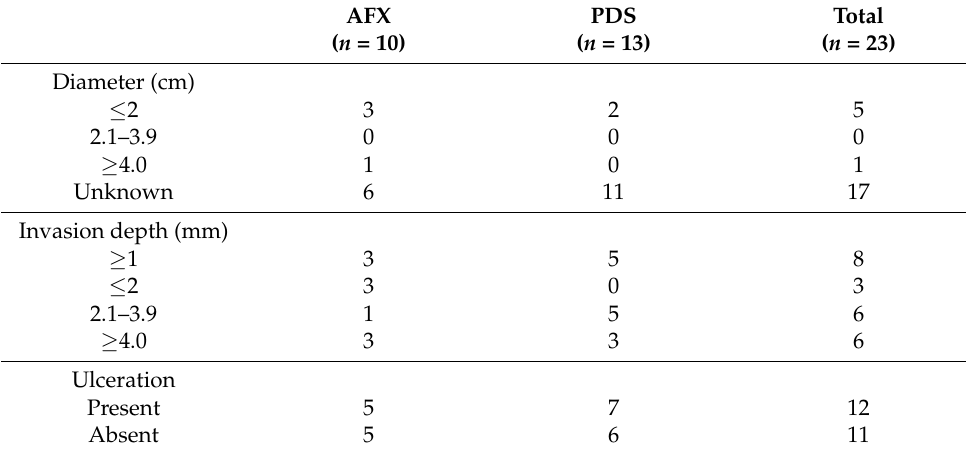
Table 1. Clinicopathological features of atypical fibroxanthoma (AFX) and pleomorphic dermal sarcoma